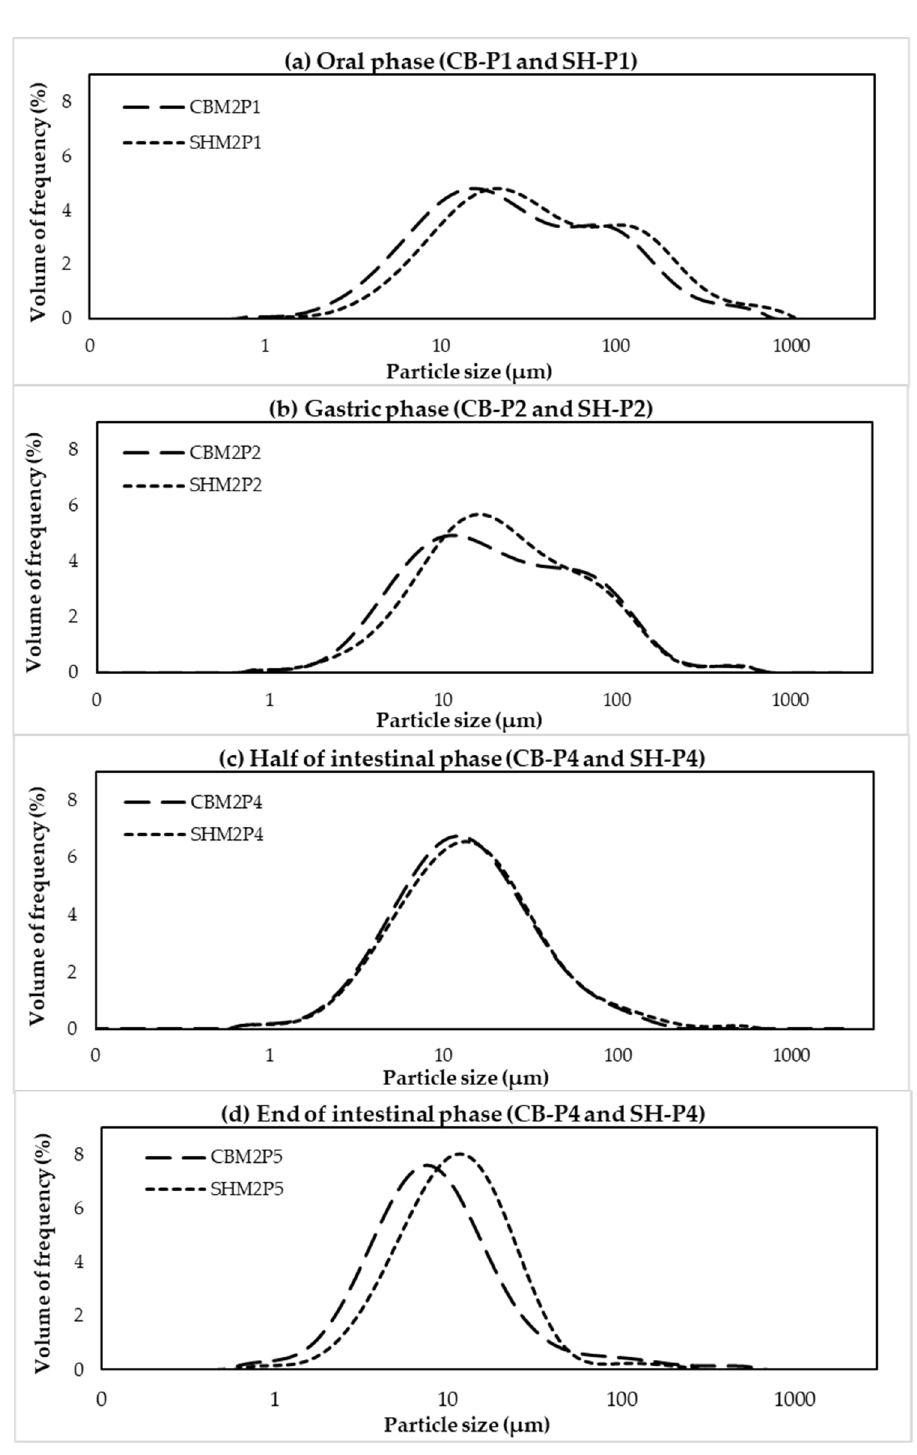
Figure 7. Particle size distribution of commercial broiler breasts (CB) and spent commercial laying hen breasts (SH) digested by method 2 and collected at end of oral phase ( a ), end of gastric phase ( b ), and half ( c ) and end ( d ) of intestinal phase.